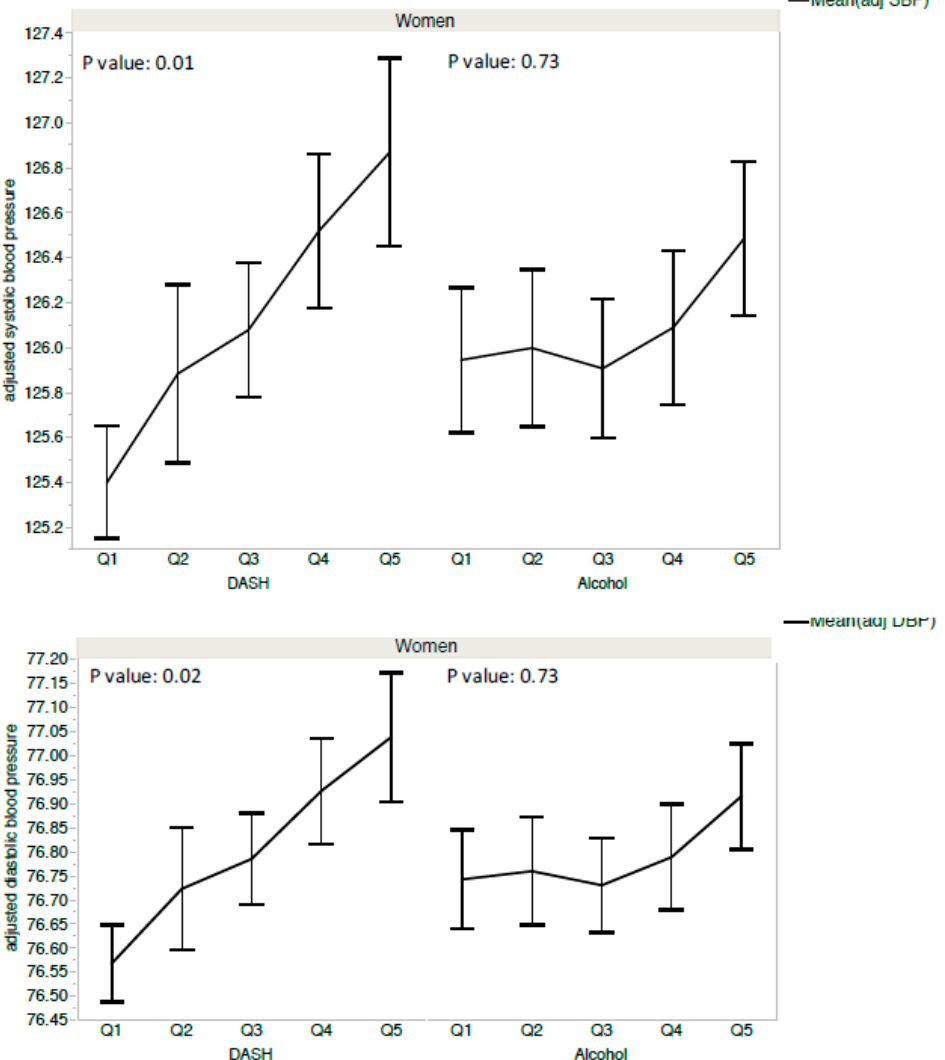
Figure 3. Blood pressure and quintiles of DASH score and alcohol consumption in women from the Esteban survey 2014–2016. Q1: better quintile of DASH scores and alcohol consumption (lowest consumption). Table 4. Adjusted BP according to quintiles of DASH scores and alcohol consumption in men and women. Q5: worst quintile of DASH scores and alcohol consumption (high) Q1: best quintile of DASH scores and alcohol consumption (lowest).